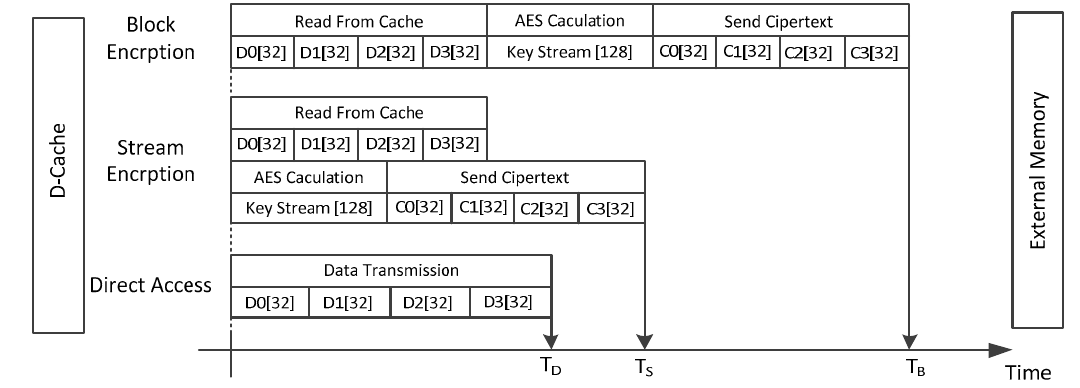
Figure 5. The processor memory access time diagram of a write-back operation from the data cache.